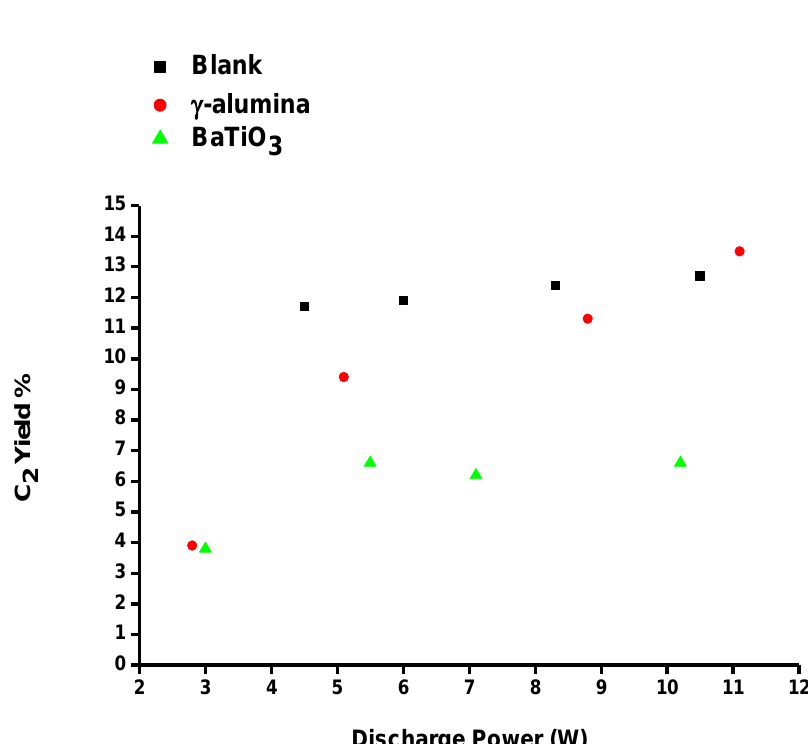
Figure 13. Yield of C 2 products as a function of discharge power for the reactor packed with BaTiO 3 and γ-alumina and the blank reactor.